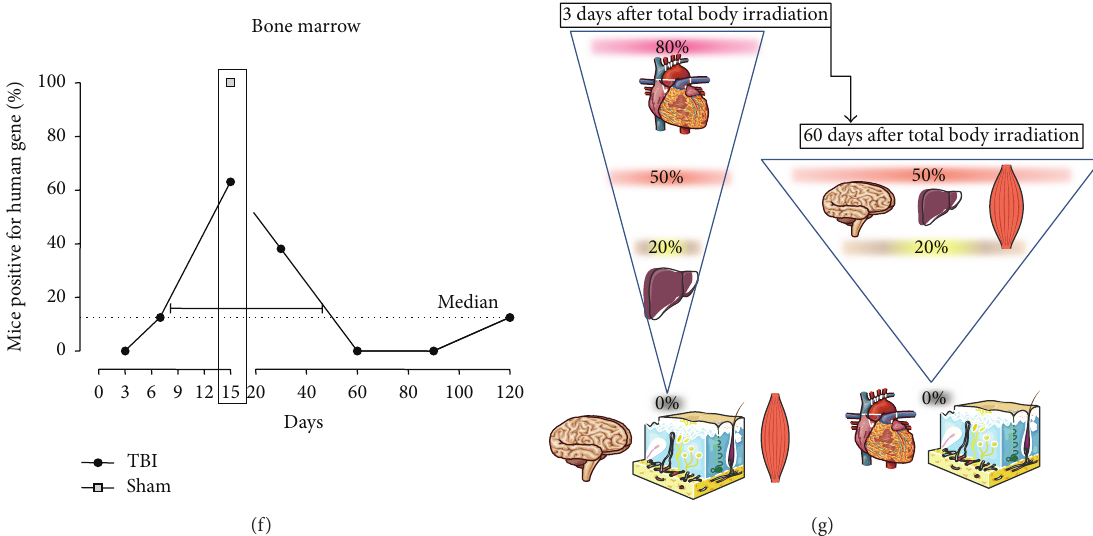
Table 5: Histological analysis of tissue at 120 days after total body irradiation at 3.5 Gray in hMSC injected mice. Positive organs Negative organs Organs Tissue Tissue Number of mice Tumour Number of mice Tumour Disruption Abnormality Disruption Abnormality Brain 1 Neg. Neg. Neg. 9 Neg. Neg. Neg. Heart 4 Neg. Neg. Neg. 6 Neg. Neg. Neg. Lung 2 Neg. Neg. Neg. 8 Neg. Neg. Neg. Liver 0 ND ND ND 10 Neg. Neg. Neg. Spleen 2 Neg. Neg. Neg. 8 Neg. Neg. Neg. Kidney 2 Neg. Neg. Neg. 8 Neg. Neg. Neg. Abdominal area Muscle 1 Neg. Neg. Neg. 5 Neg. Neg. Neg. Stomach 0 ND ND ND 8 Neg. Neg. Neg. Duodenum 1 Neg. Neg. Neg. 9 Neg. Neg. Neg. Jejunum 1 Neg. Neg. Neg. 9 Neg. Neg. Neg. Ileum 1 Neg. Neg. Neg. 9 Neg. Neg. Neg. Cecum 1 Neg. Neg. Neg. 9 Neg. Neg. Neg. Colon proximal 3 Neg. Neg. Neg. 7 Neg. Neg. Neg. Colon distal 2 Neg. Neg. Neg. 8 Neg. Neg. Neg. Posterior leg (right) Skin 0 ND ND ND 10 Neg. Neg. Neg. Muscle 1 Neg. Neg. Neg. 7 Neg. Neg. Neg. Bone 5